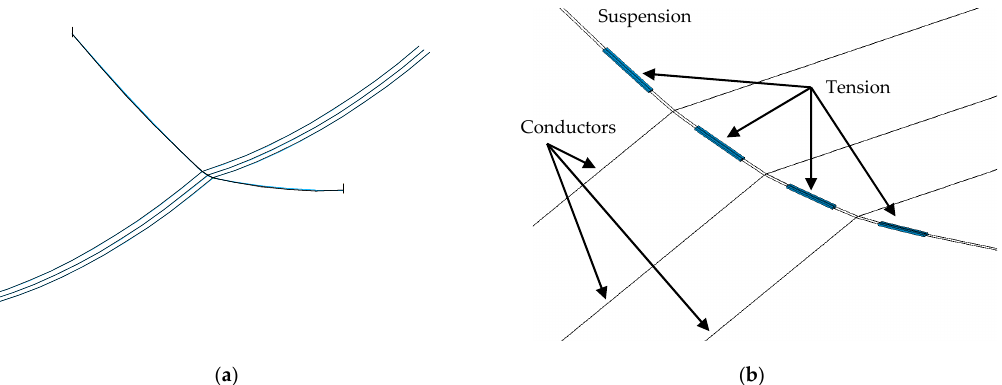
Figure 5. Unscaled deformation of CRS by dead load (Black: undeformed. Blue: deformed). ( a ) Single span, ( b ) detail of cross-rope connection.